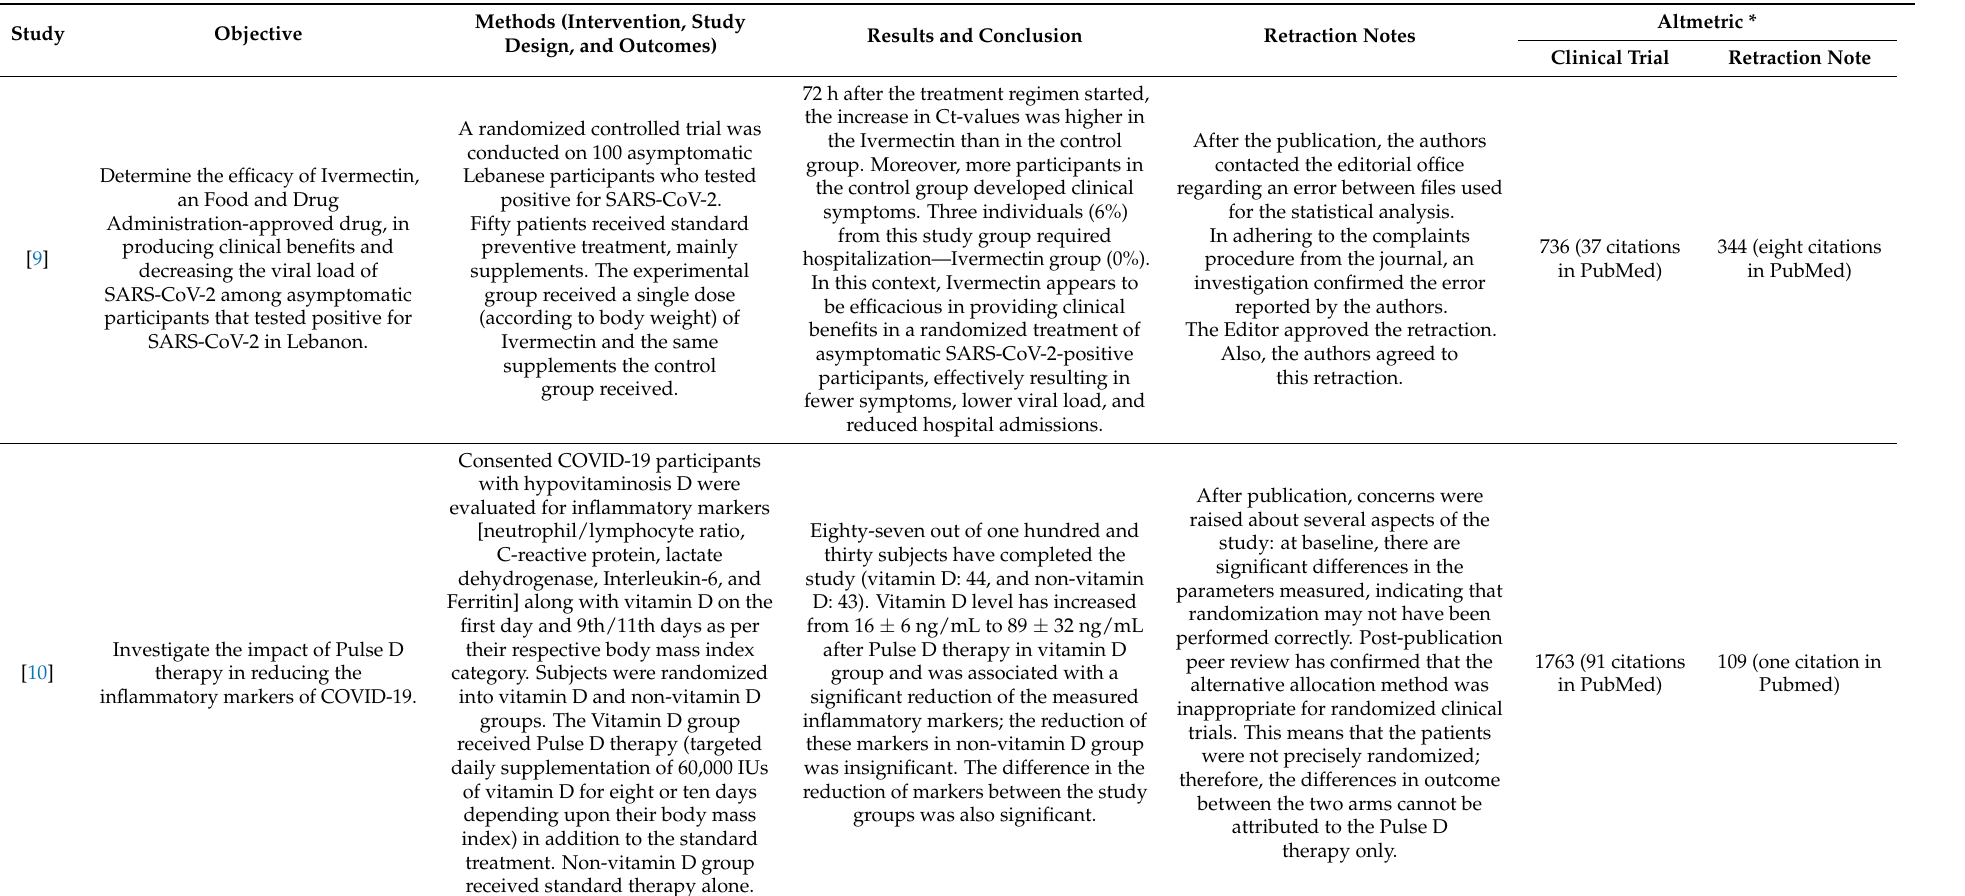
Table 3. Characterization of the clinical trials about Coronavirus Disease (COVID)-19 retracted after